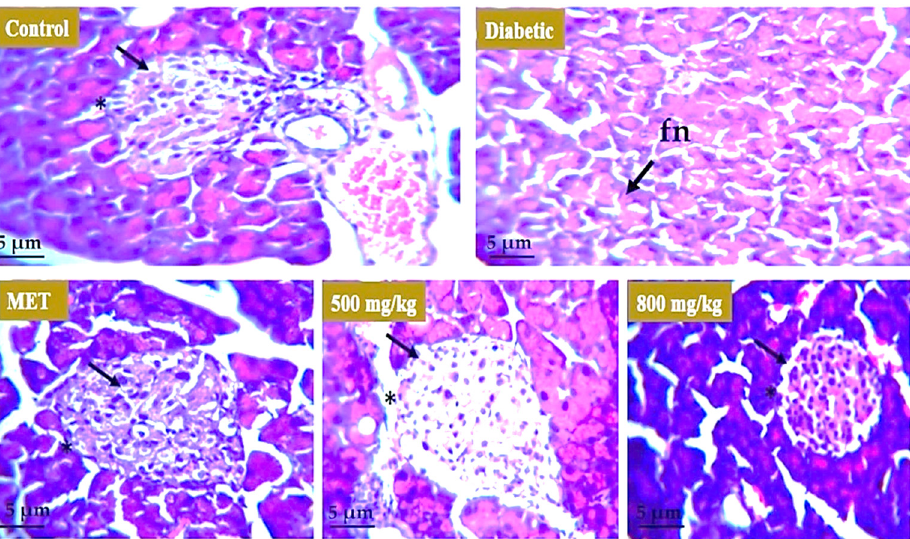
Figure 10. Effect of aqueous extract on the pancreatic tissue. Pancreas of normal mice revealed intact boundary and normal morphology of B cells. The diabetic mice group revealed focal necrosis (arrow) in pancreatic tissue due to the effect of STZ. Mice treated with metformin showed restoration of intact structure of islets of Langerhans. Both 500 mg/kg and 800 mg/kg doses of extract restored the boundary of islets of Langerhans as well as the morphology and number of beta cells (*). fn = focal necrosis.